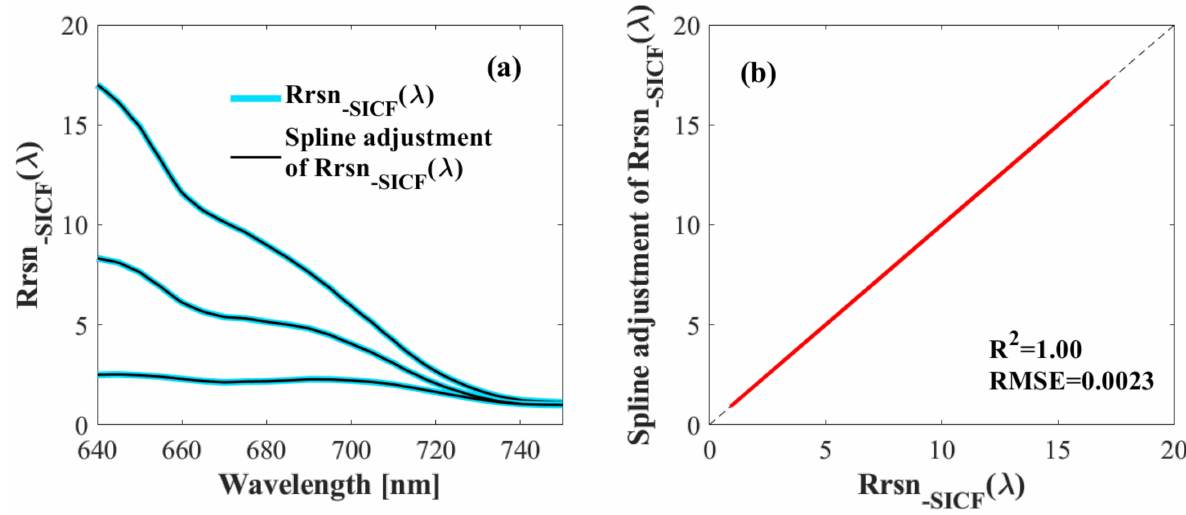
Figure 6. ( a ) Three examples from the database of 7200 spectra showing the comparison of normalized remote-sensing reflectance without SICF contribution ( Rrsn − SICF ( λ ) ) spectra (blue) with its corresponding spline adjustment (black). ( b ) Normalized remote-sensing reflectance without SICF contribution ( Rrsn − SICF ( λ ) ) vs. adjusted normalized remote-sensing reflectance without SICF contribution in the spectral range between 640 and 750 nm for all the wavelengths in this